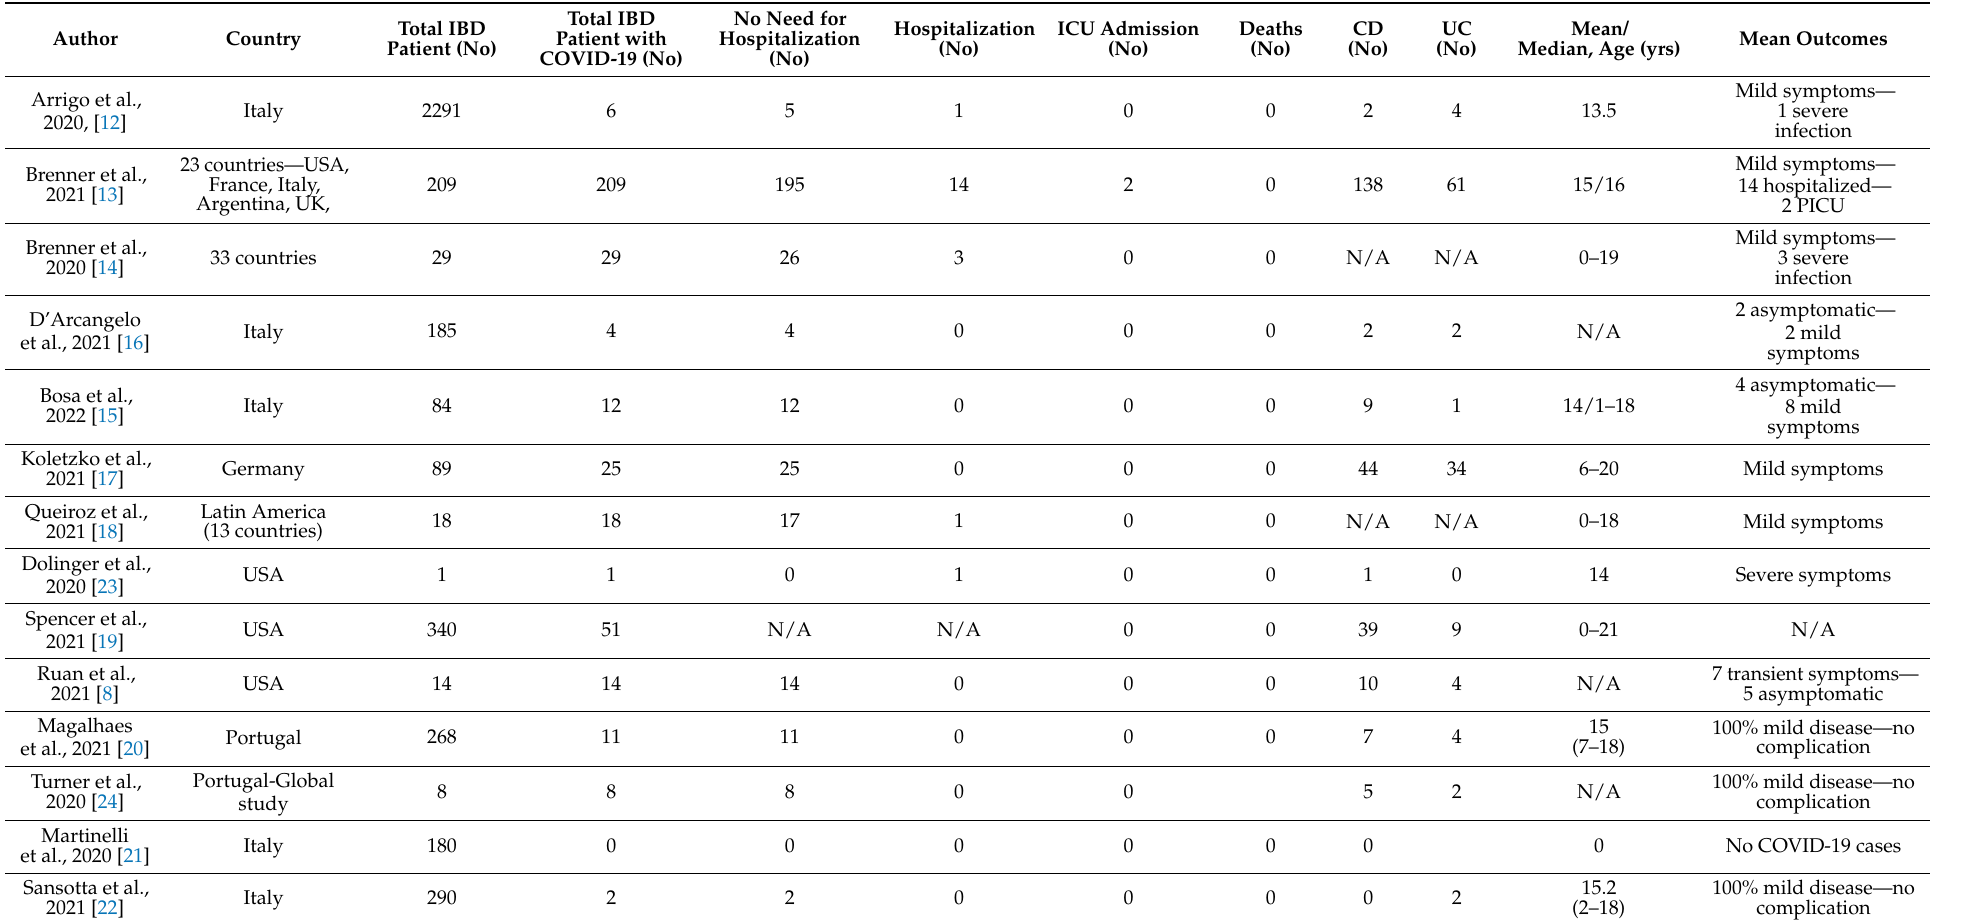
Table 1. Characteristics of studies included in the systematic review reporting data on the occurrence of COVID-19 in pediatric patients with